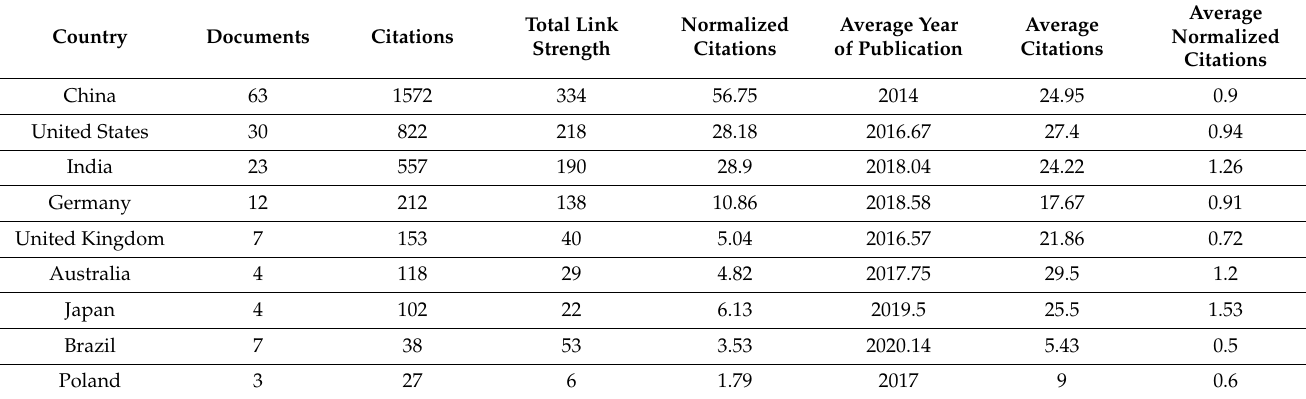
Table 6. Countries with high impacts based on normalized citations.